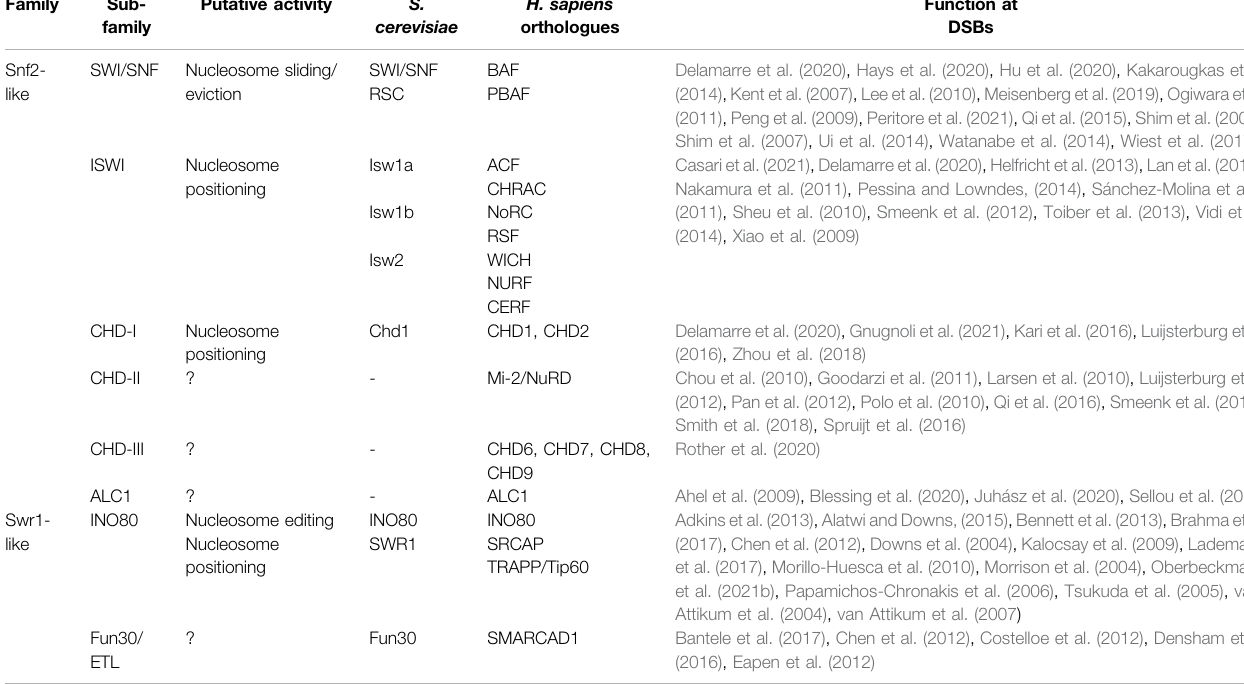
TABLE 1 | Overview of nucleosome remodeler sub-families and their members. Family